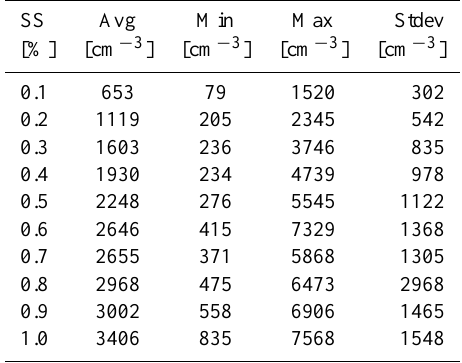
Table 1. The average, minimum, maximum and standard deviation values of N CCN at the different SS as determined from the scanning CCNC.